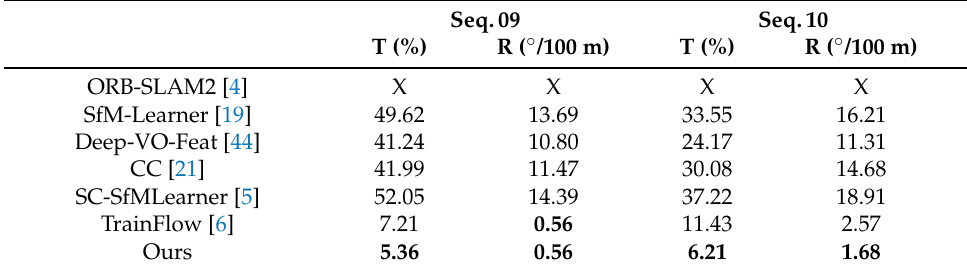
Table 4. The VO results on medium-amplitude-motion scene (stride = 3). As we can see, ORB-SLAM2 was hard to initialize and lost track, while our approach outperformed the others by a clear margin.